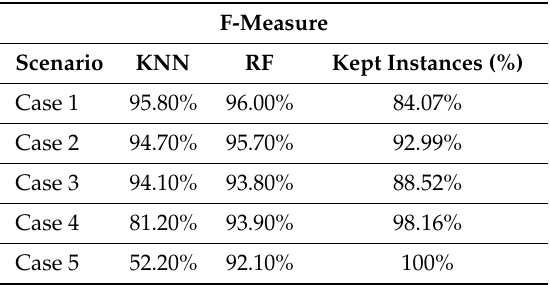
Table 6. F-measure value with different cleansing levels.